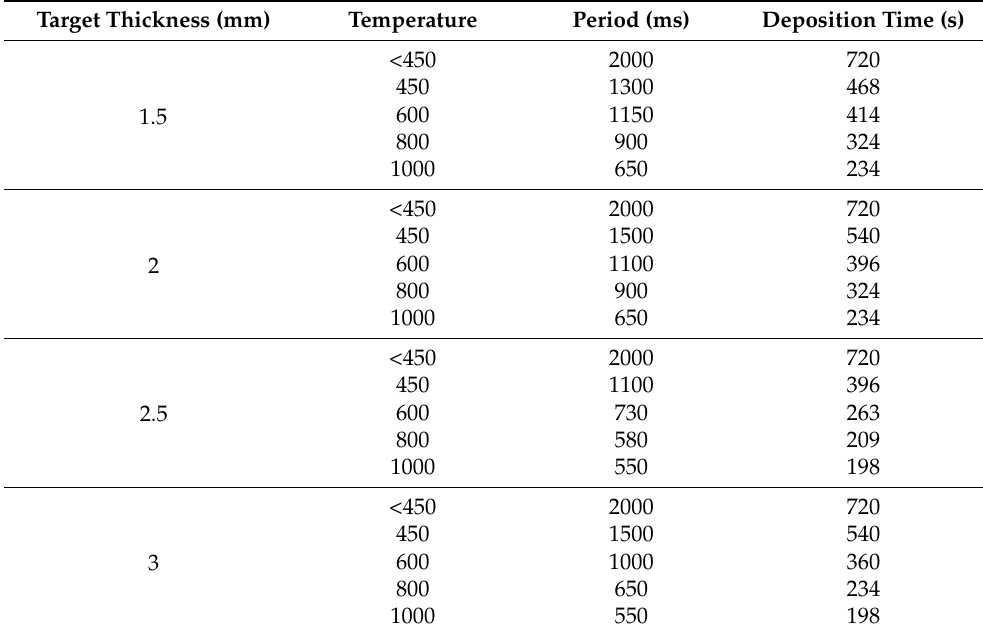
Table 1. Parameters of hot nickel target sputtering in the